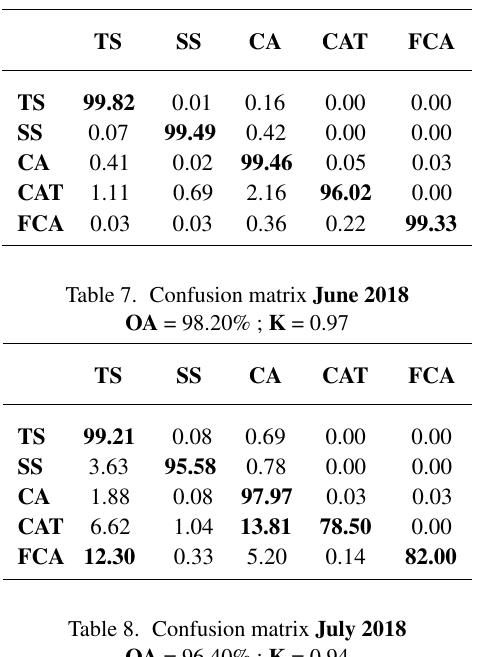
Table 6. Confusion matrix May 2018